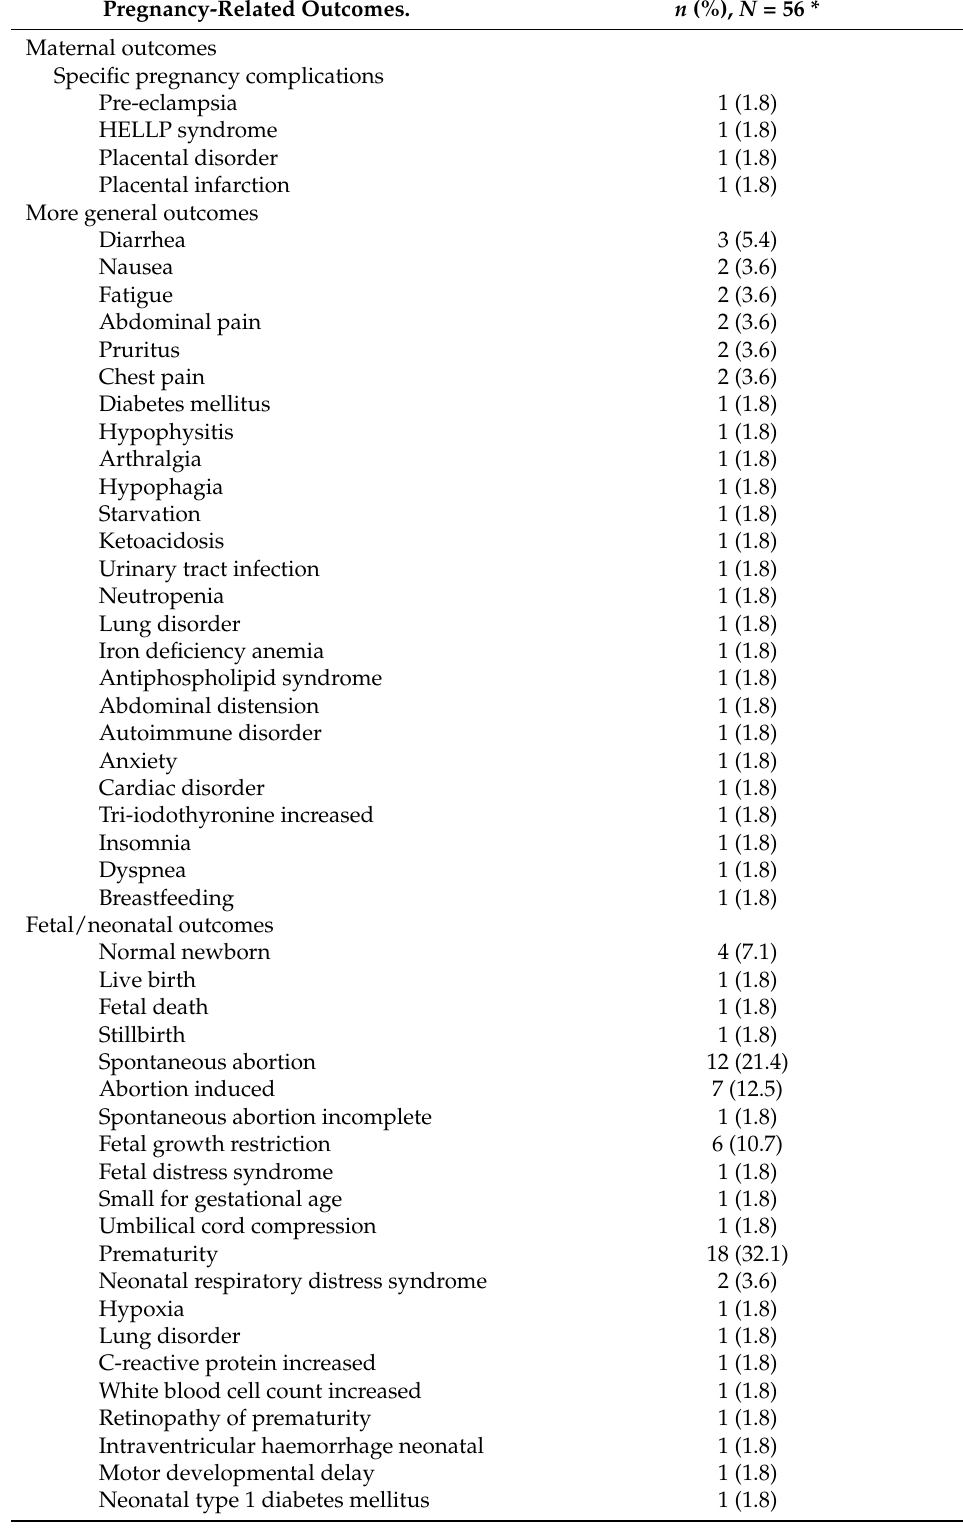
Table 2. Pregnancy-related outcomes reported on immune checkpoint inhibitors in VigiBase ® as of 30 April 2022. Pregnancy-Related